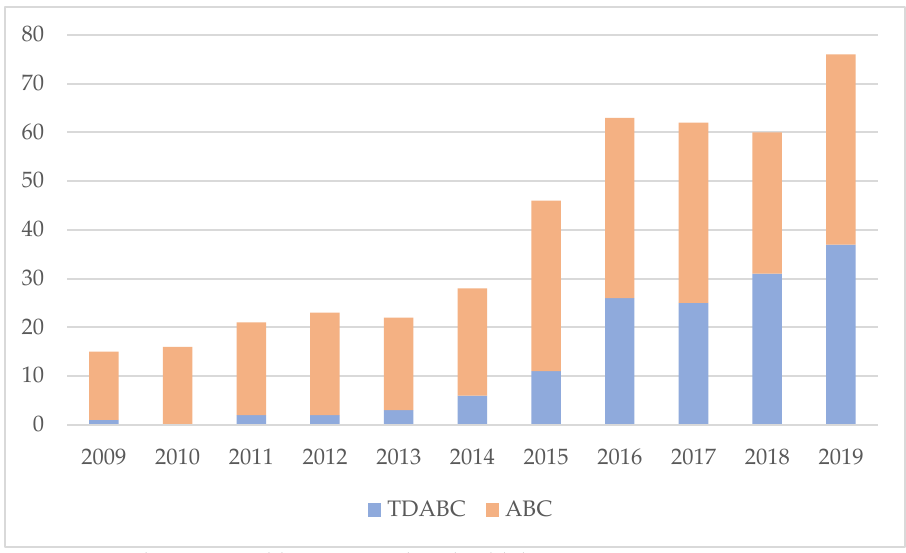
Figure 2. ABC and TDABC publication trends in health literature.